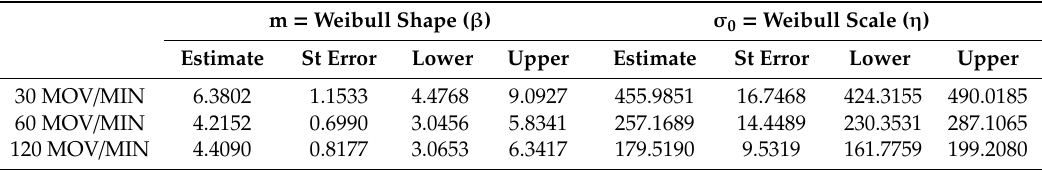
Table 4. Weibull statistics of the time to failure.